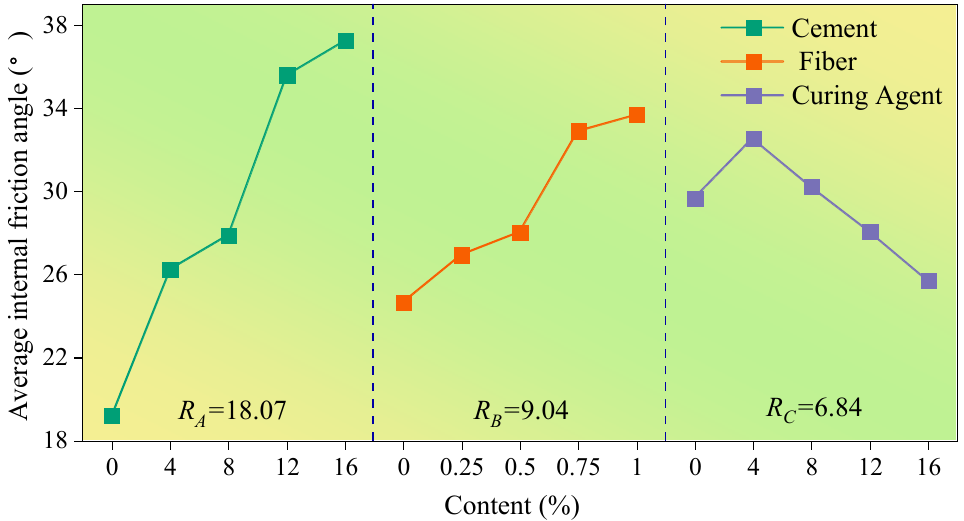
Figure 6. The influence of various factors on the internal friction angle.